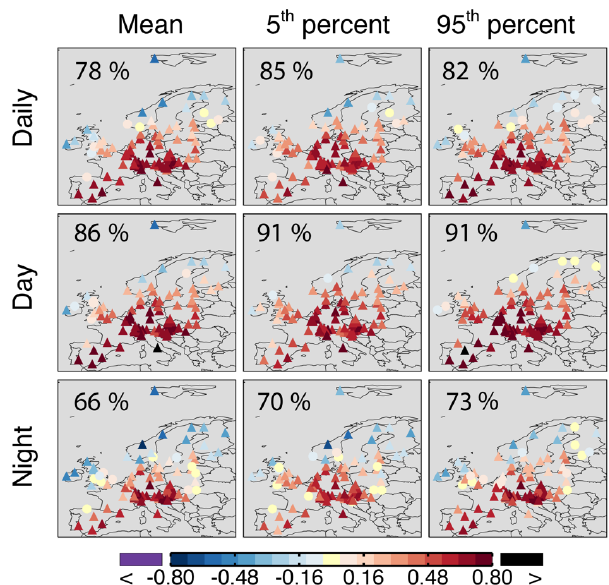
Figure 11. Site-by-site correlations (triangle: P -value < 0.05 under a T -test; circular: P -value > 0.05) between the monthly mean 2m temperature and monthly mean, 5th, and 95th percentile ozone in the daily data, and during daytime as well as nighttime. Also shown in each panel are the fraction of sites for which significant correla- tion